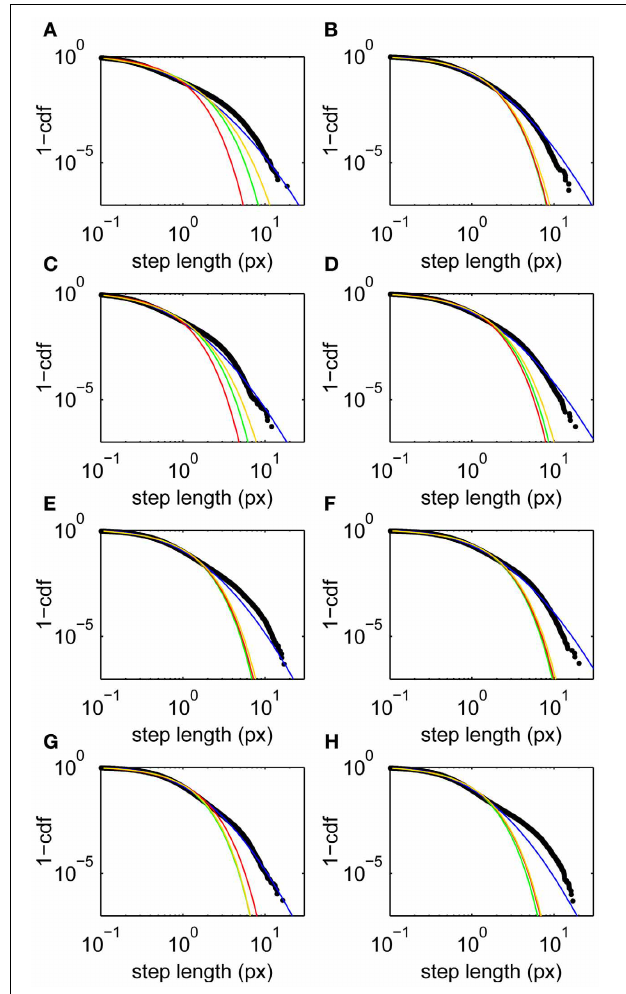
FIGURE 2 | Step length upper cumulative distribution functions and fits for all subjects. Data (black) and fits to lognormal (blue), Weibull (yellow), power law with exponential cutoff (green), and exponential (red) distributions. (A–H) Subjects 1–8, respectively. Fits are maximum likelihood estimates to the tail above step lengths of 0.1px using the methods of Clauset et al. (2009).